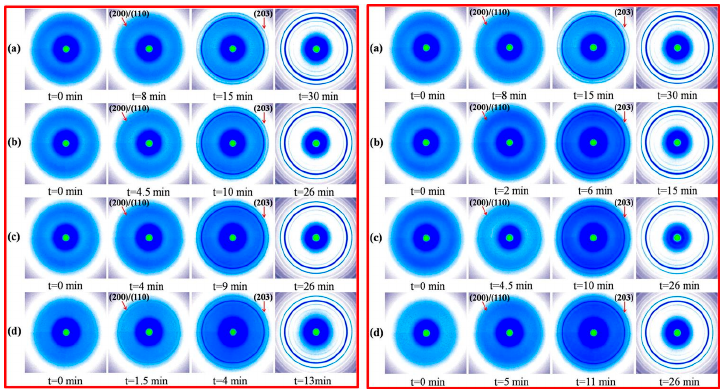
Figure 14. Left panel : Selected 2D-WAXD patterns of ( a ) neat PLA; ( b ) PLA-rGOw 0.5; ( c ) PLA-rGOw 1.0; and ( d ) PLA-rGOw 2.0 isothermally crystallized at 135 °C. Right panel : selected 2D-WAXD patterns of ( a ) neat PLA; ( b ) PLA-rGOp 0.3; ( c ) PLA-rGOp 0.6; and ( d ) PLA-rGOp 1.0 isothermally crystallized at 135 °C [70].